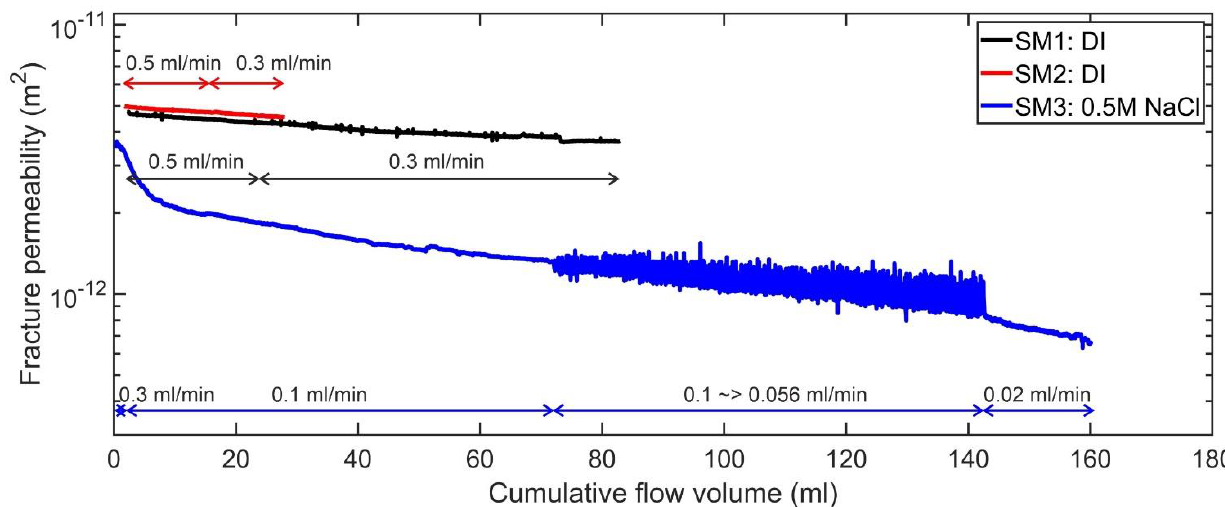
Figure 3. Fracture permeability evolution in stage 1 after pressure build-up ( P c : 10 MPa and P p : 1 MPa) versus cumulative flow volume. Temperature is 25 °C. Flow rates are indicated.